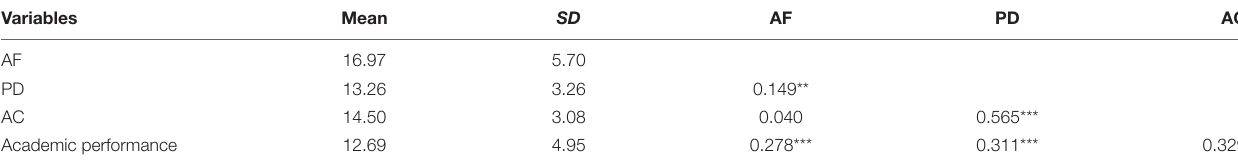
TABLE 4 | Descriptive statistics of the study